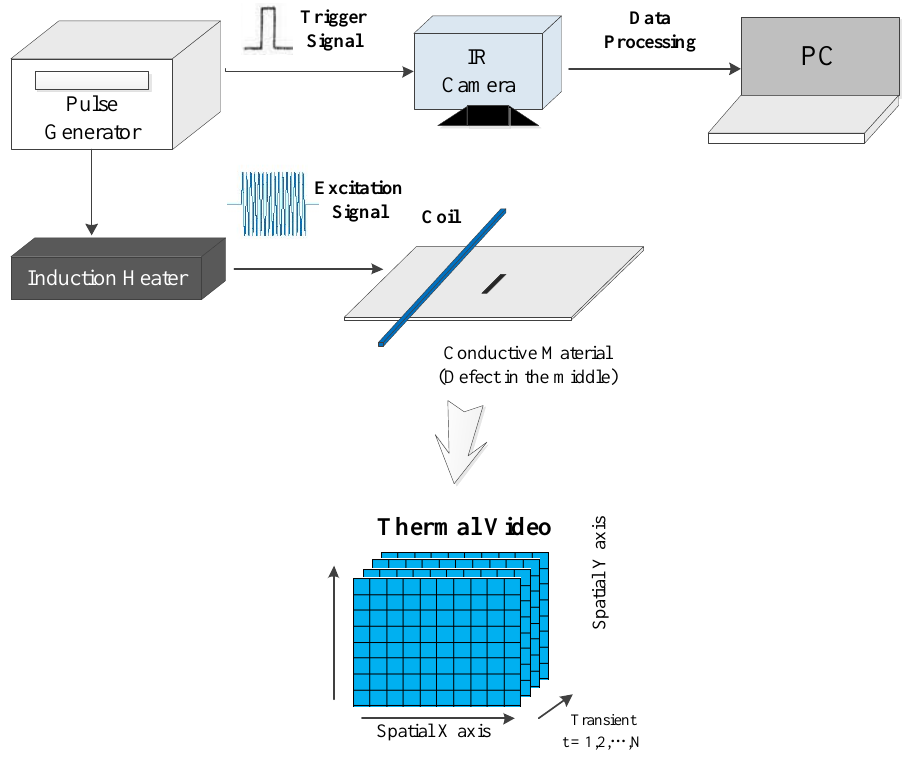
Figure 1. ECPT schematic diagram.